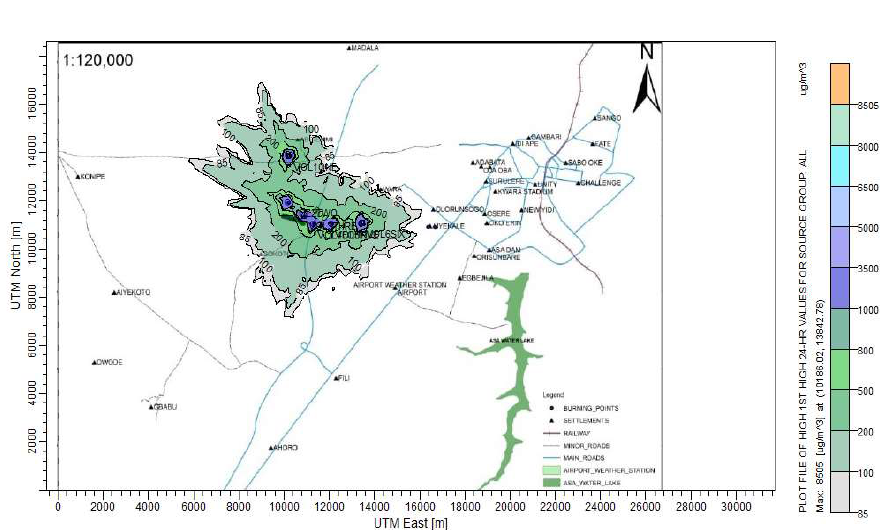
Figure 11. Isopleth of 24-h ground level SO x from Sokoto-Aiyekale dump site.